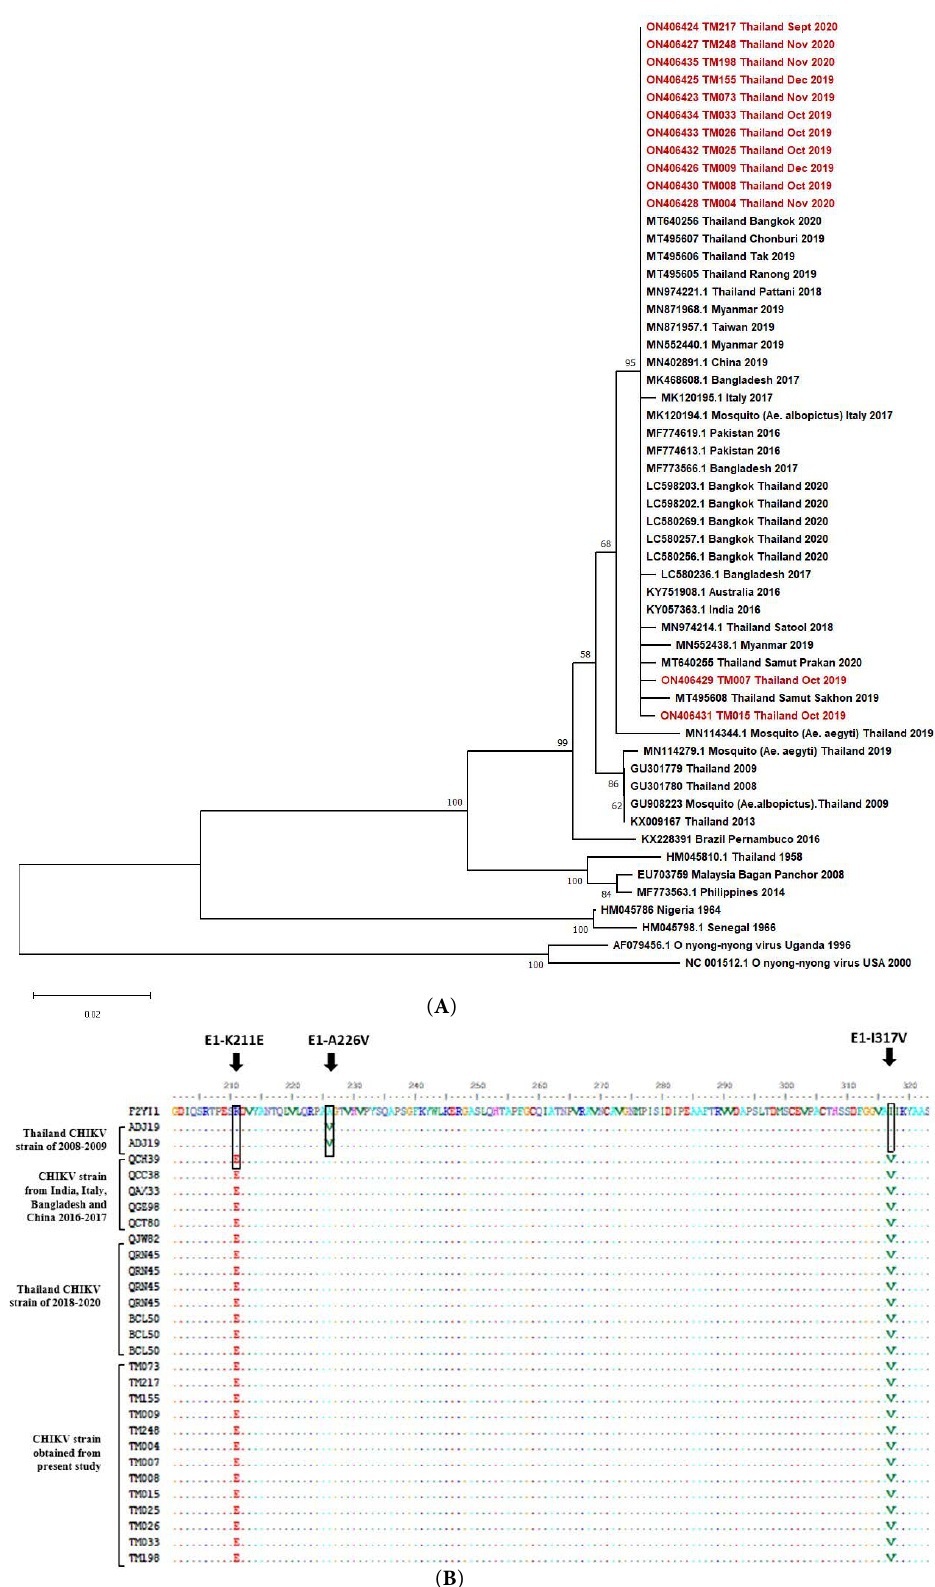
Figure 4. Sequence analysis of the isolated CHIKV strains of patients. ( A ) Phylogenetic analysis of partial CHIKV E1 protein using the maximum-likelihood method with 1000 bootstrap replicates represented at the brand notes. CHIKV strains isolated from this study are shown in red text. ( B ) Alignment of amino acid sequences of isolated CHIKV strains in this study.